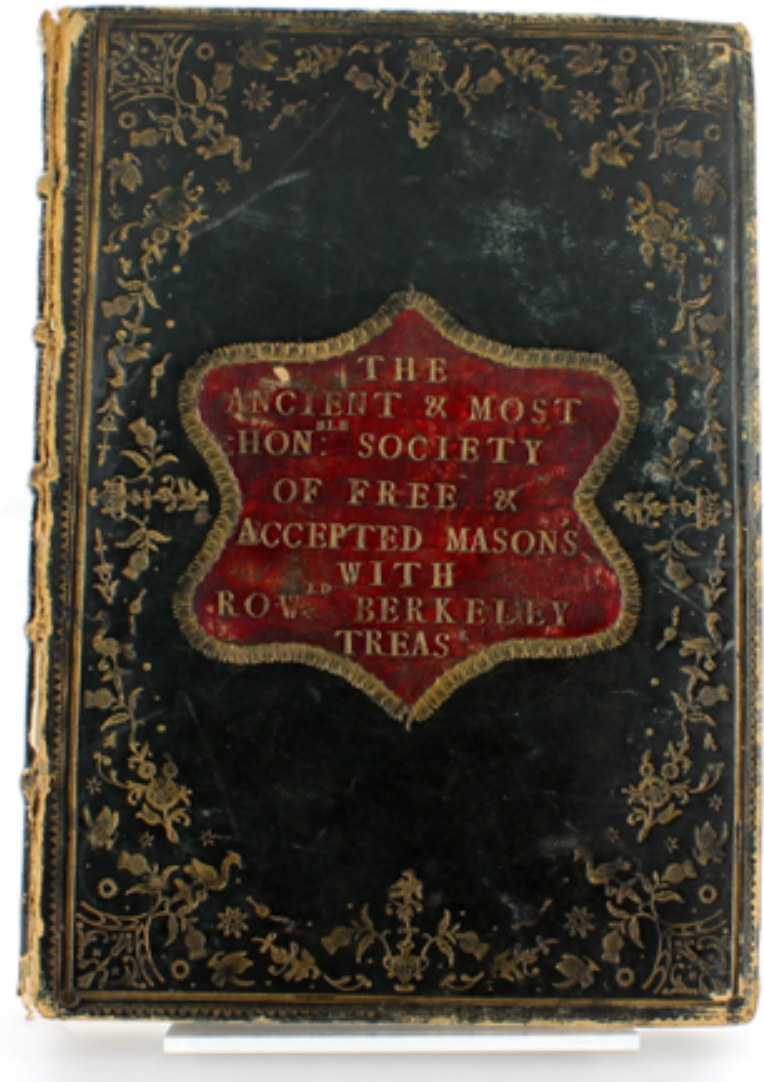
Fig. 20. Upper cover of the 1768 accounts book of the Moderns Grand Lodge. Copyright and reproduced by permission of the Museum of Freemasonry, London.